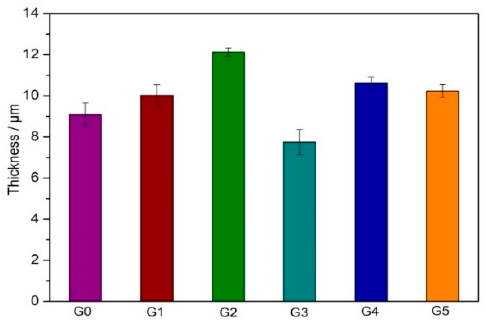
Figure 5. The thickness of coated samples with di ff erent concentration